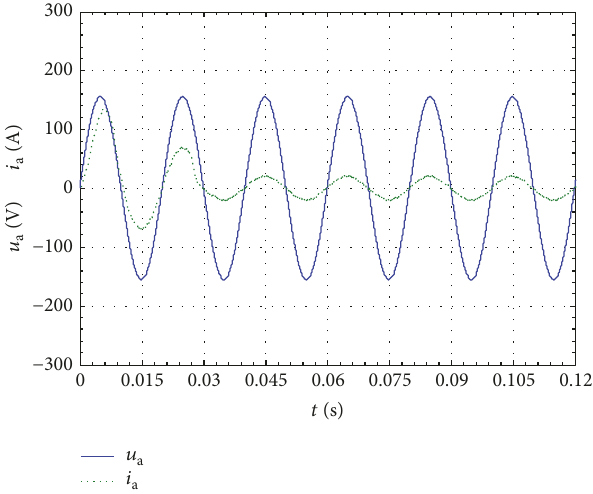
Figure 7: Waveforms of active power 𝑃 and reactive power 𝑄 .